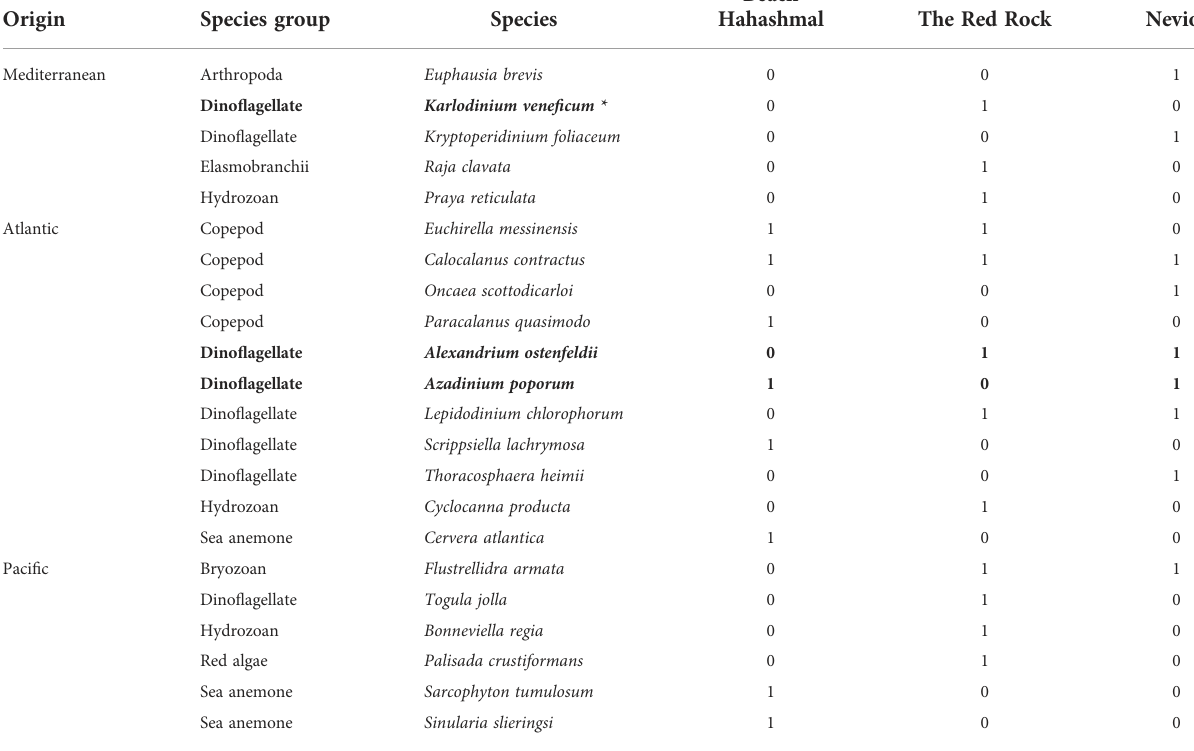
TABLE 4 Non-indigenous species found from eDNA in this